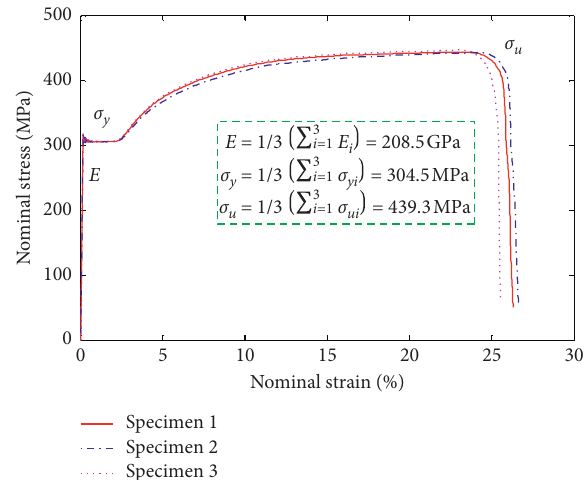
Figure 3: Recorded nominal stress-strain curve of uncorroded